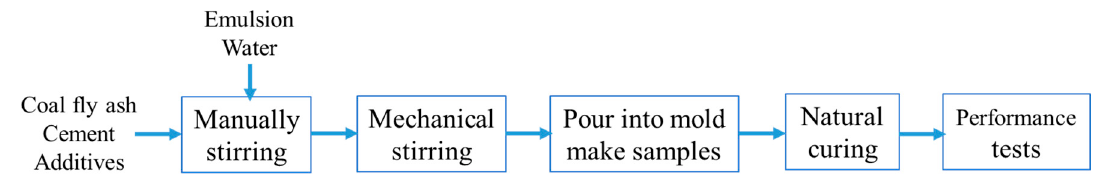
Figure 1. Preparation and testing process of coal fly ash-based gas-sealing coating.